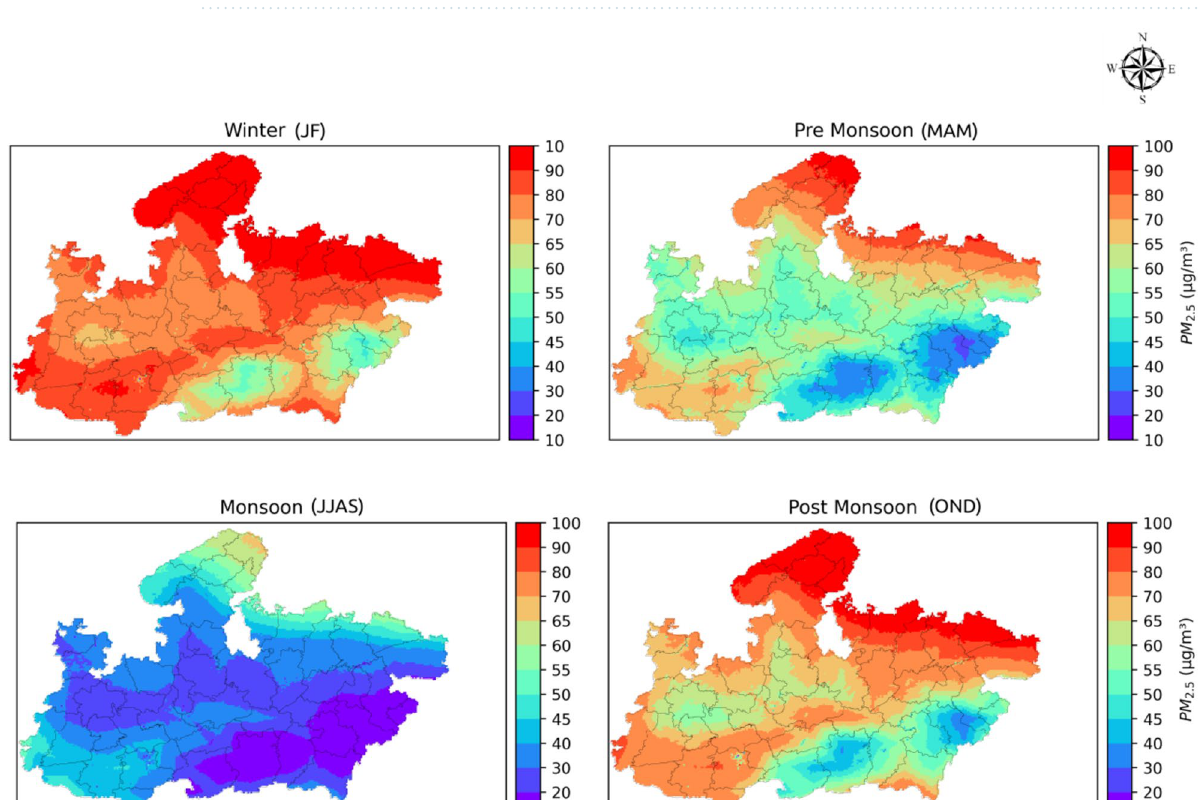
Figure 5. Season average (2018 and 2019) map of daily PM 2.5 concentration over Madhya Pradesh. The figure was generated using Python (version 3.7, https ://www.pytho